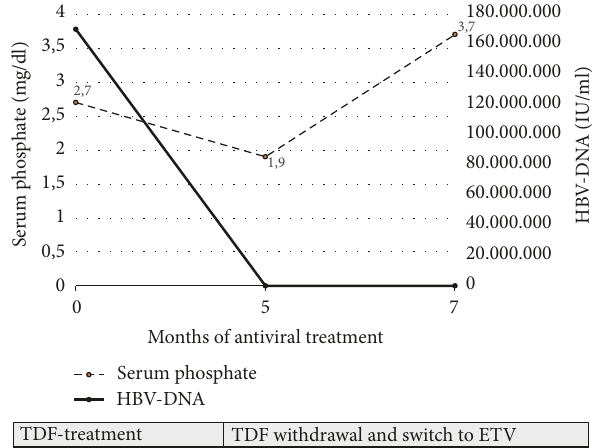
Figure 1: Serum phosphate and HBV-DNA levels over Tenofovir treatment and after its